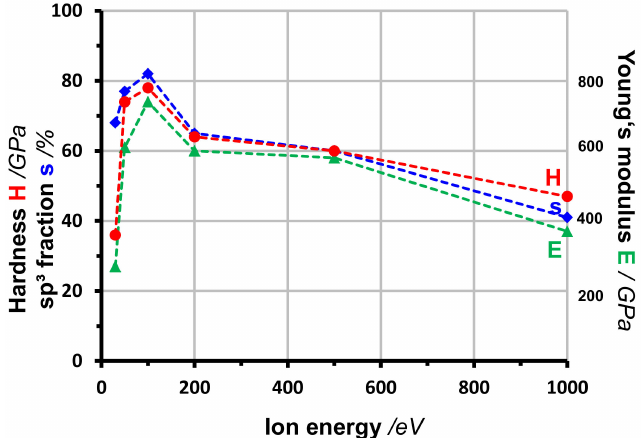
Figure 3. sp 3 fraction, Young’s modulus and hardness of carbon films, deposited by MSIBD at room temperature, in dependence on the ion energy (data from